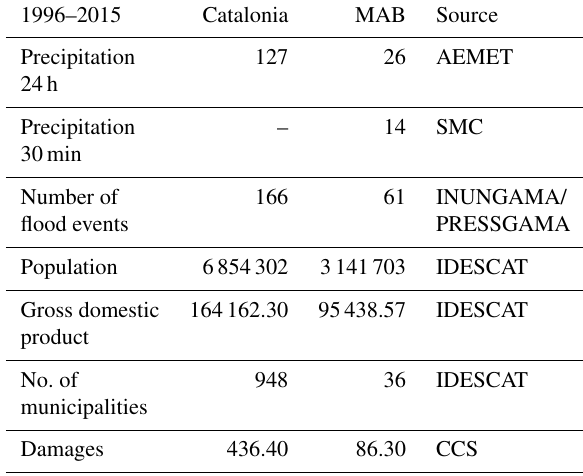
Table 1. Summary of the data used. Precipitation refers to the number of meteorological stations considered; the number of flood events is the total sum for the period 1996–2015; the average pop- ulation is the total number of inhabitants; the average GDP is in millions of euros; the damages refer to the compensation paid by the CCS for the 1996–2015 period in millions of